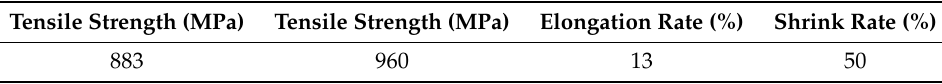
Table 3. Mechanical properties of Ti6Al4V alloy